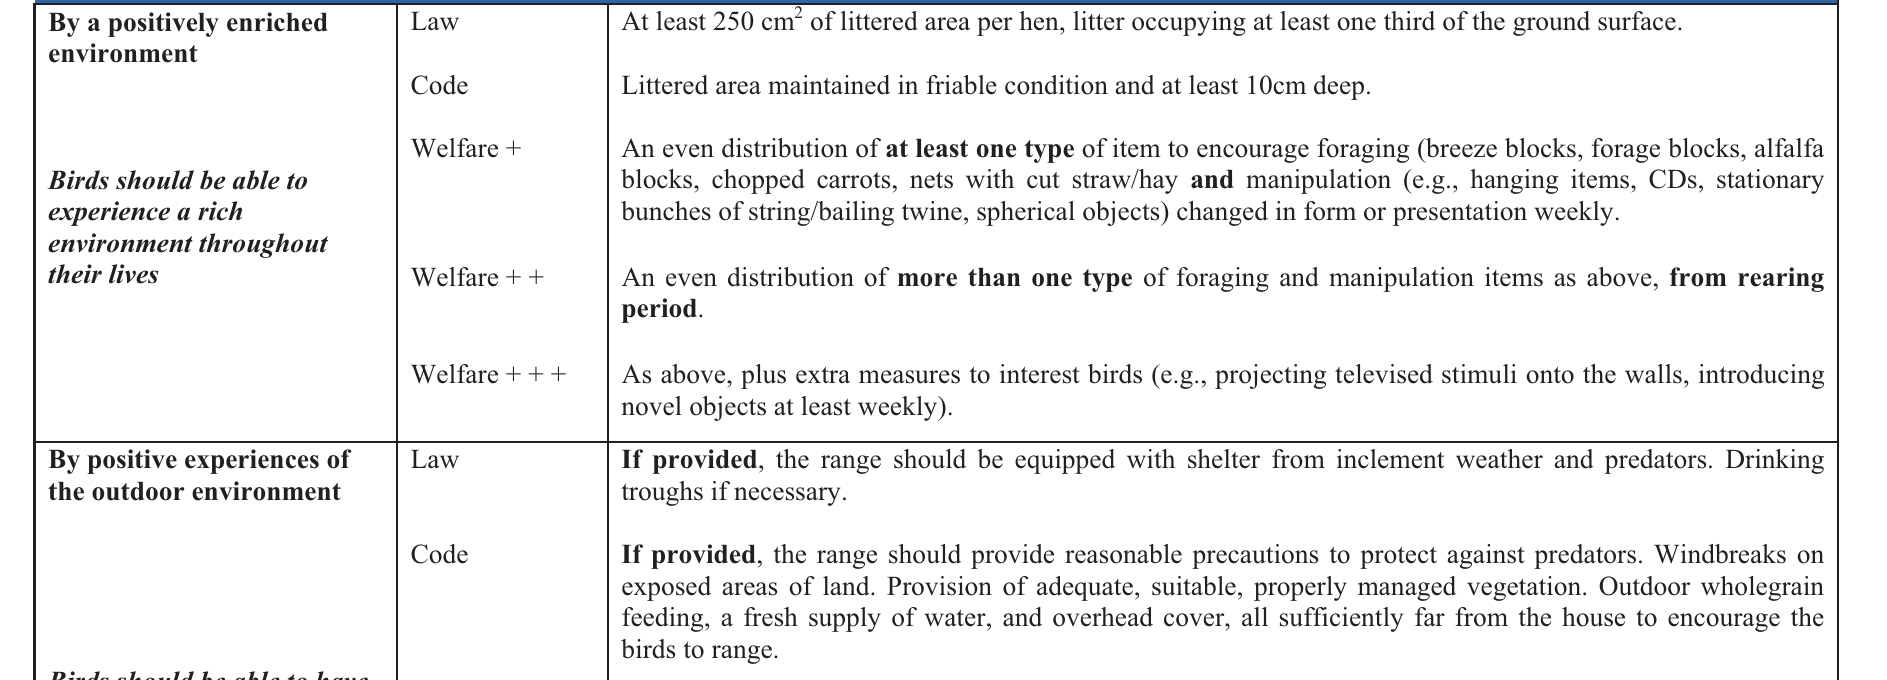
FAWC ‘Good life’ opportunity :